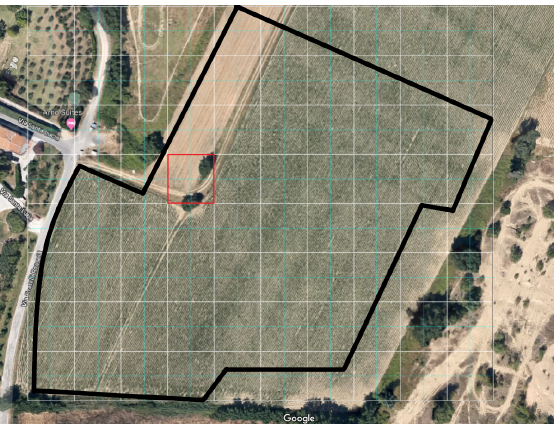
Figure 20. Scenario 2: Area of Interest [31].